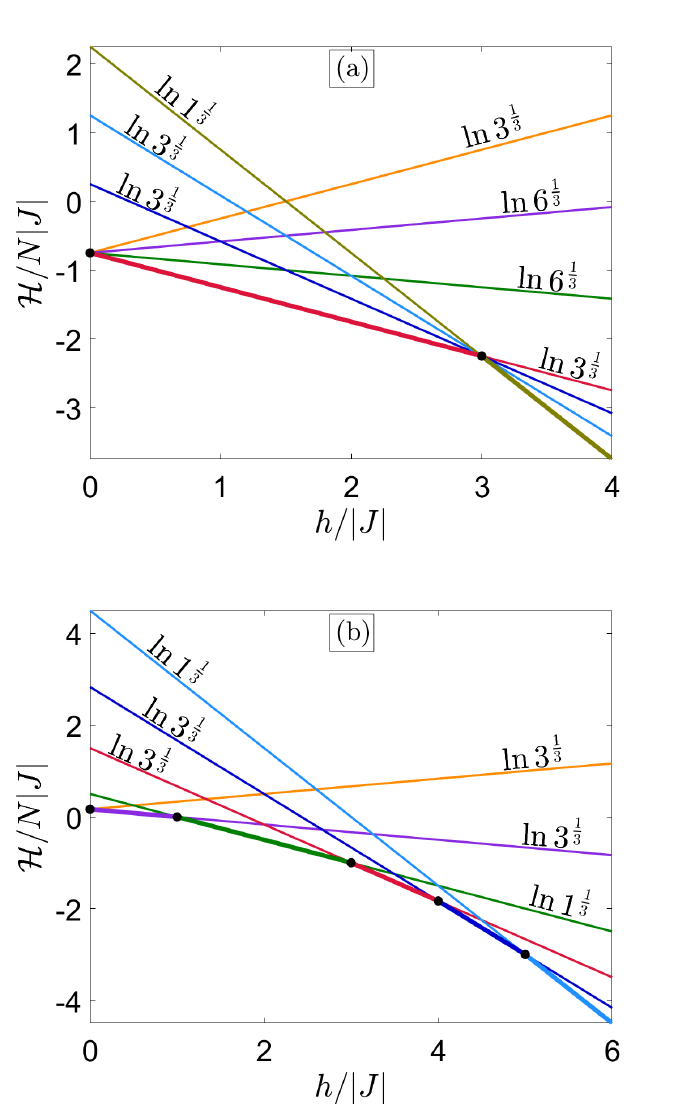
Figure 2. Energy levels of the T cluster with s = 3/2 for ( a ) D / | J | = 0 and ( b ) D / | J | = − 1 as functions of the field. The thick lines correspond to the ground-state energy levels within given field ranges. The listed entropy density values show degeneracies of the respective energy